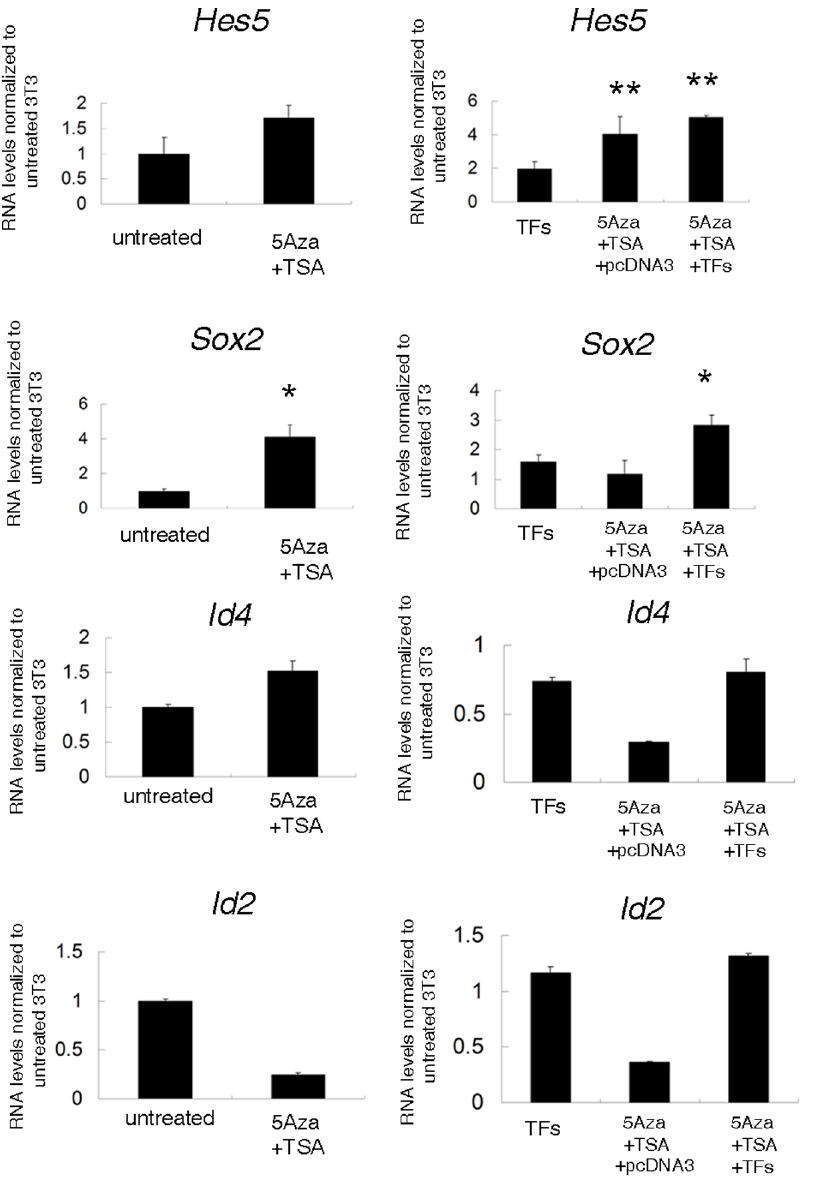
Figure 8. Expression of positive transcriptional regulators of myelin gene expression in manipulated NIH3T3. NIH3T3 cells were treated as described in figure 7. Experiments were performed in two independent cultures. Results are expressed as mean 6 standard error (SE) and statistically compared with the levels detected in untreated NIH3T3 cells using two tailed Student’s t tests (*p , 0.05, **p , 0.01, ***p , 0.001).